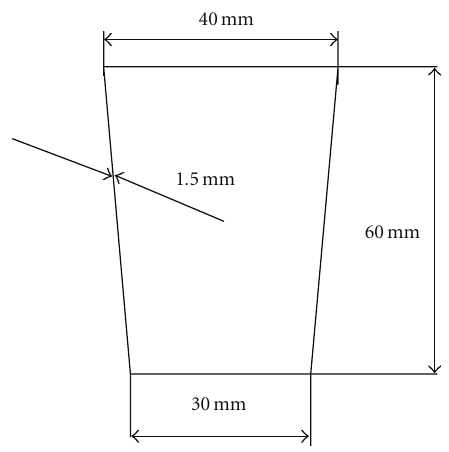
Figure 4: Schematic diagram of stainless steel mold.